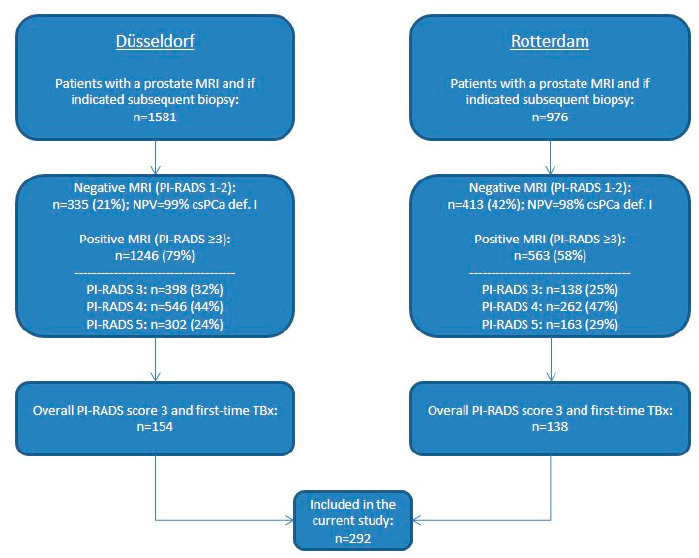
Figure 1. Flowchart of patients included in this study. MRI: magnetic resonance imaging; PI-RADS: Prostate Imaging Reporting and Data System; NPV: negative predictive value; csPCa: clinically significant prostate cancer; def.: definition; TBx: targeted biopsy.